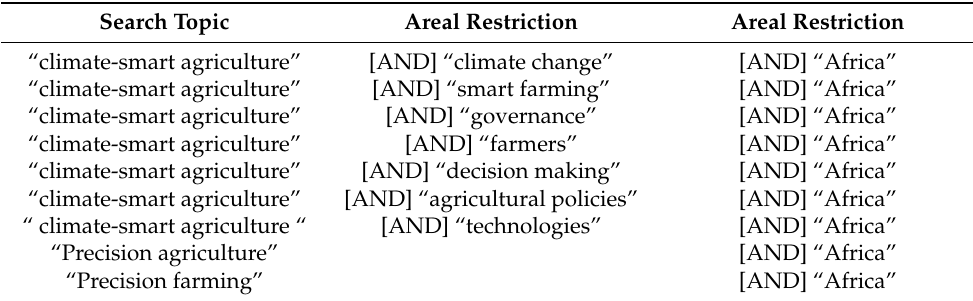
Table 1. Topics used in Scopus and Web of Science collection databases to search and retrieve published documents on climate-smart agriculture in Africa. Search